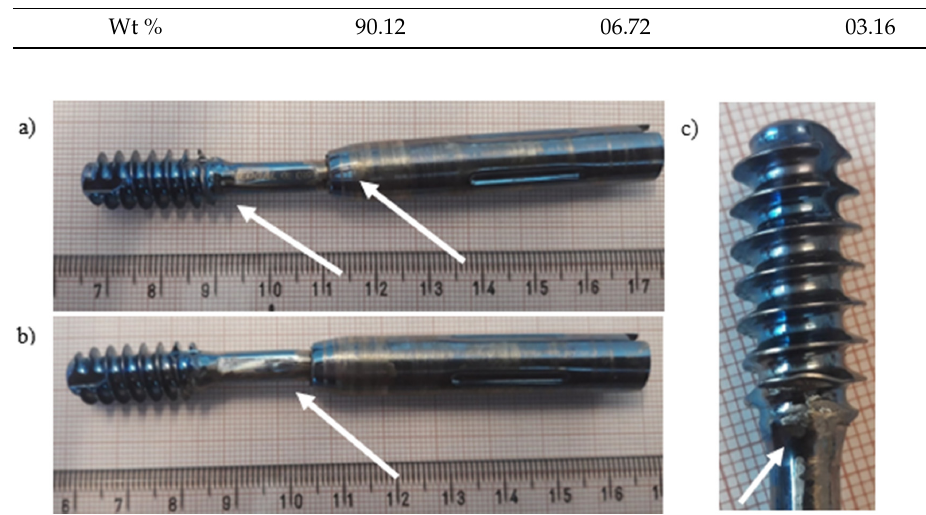
Figure 10. Visual inspection of the exploited telescopic lag screw (number 7 in Figure 9b) of the titanium implant: multiple cracks found on both sides of the telescopic lag screw ( a , b ); broken thread ( c ).